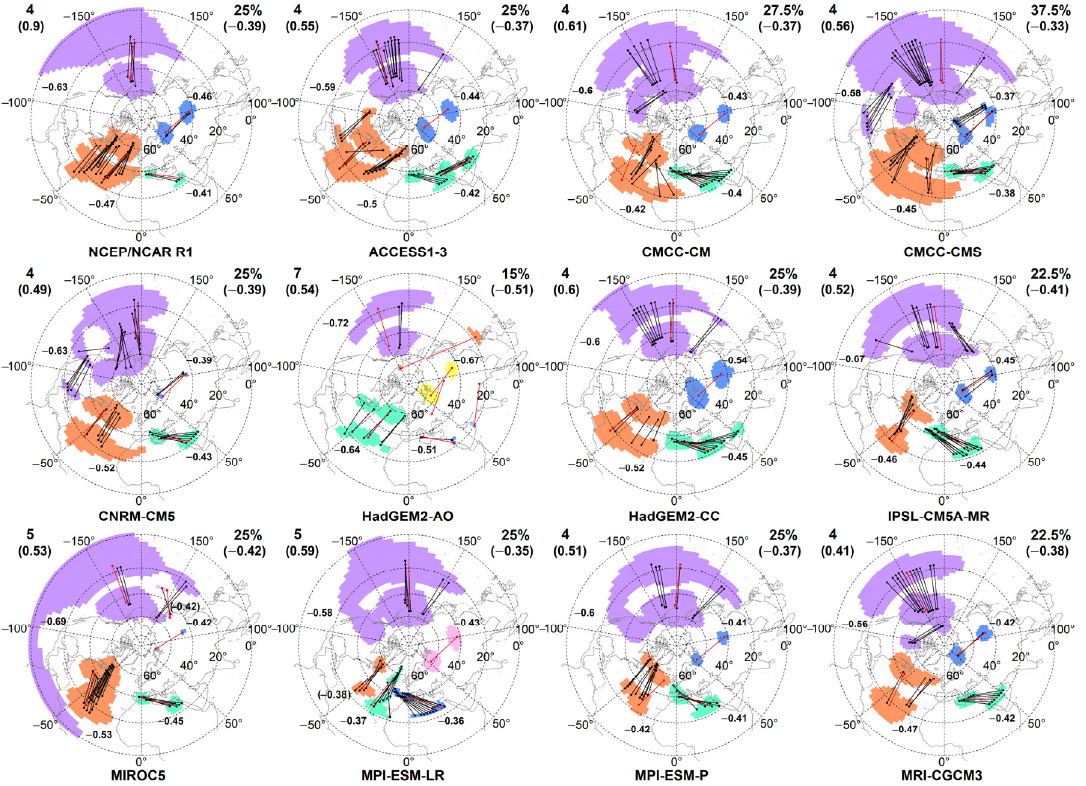
Figure 5. Most similar CP maps of the NCEP/NCAR R1 and 11 GCMs in the period 1976–2005. Interpretation of the maps is similar to that of Figure 1. The MCC max values corresponding to the maps are below the number of clusters. Correlations associated with the ACs are texted near the clusters. Texts without brackets denote clusters that correspond to the reference clusters PAC, ATL, MED, and ASIA in counterclockwise order. Texts in round brackets denote other clusters with ACs associated with correlations lower than –0.35. The MCC max values are available in Table S5, while details (e.g., geographical coordinates of the ACs and frequencies of the associated clusters) are available in Table S6 in the Supplementary